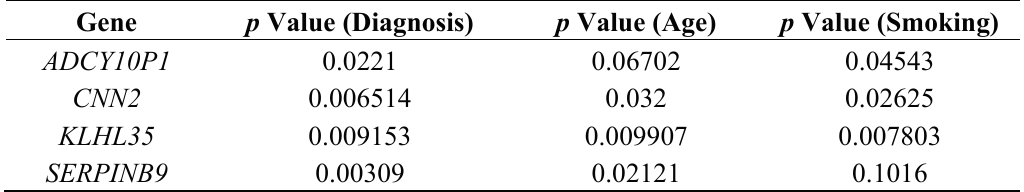
Table 4. Genes demonstrating differential DNA methylation with respect to AAA, age, and